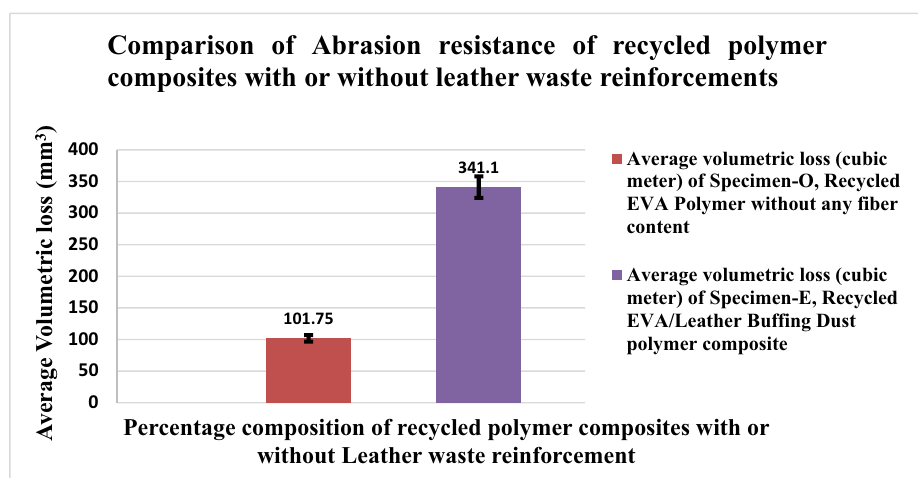
Figure 41: Comparison of abrasion resistance ( mm 3 ) of recycled EVA polymer composites with or without leather bu ffi ng